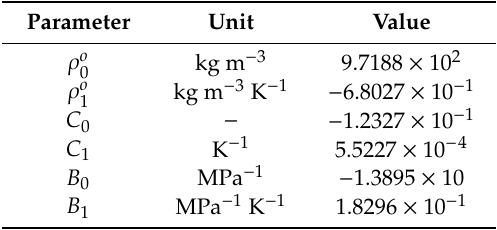
Table 2. N-hexadecane parameter of Tait equation [22].